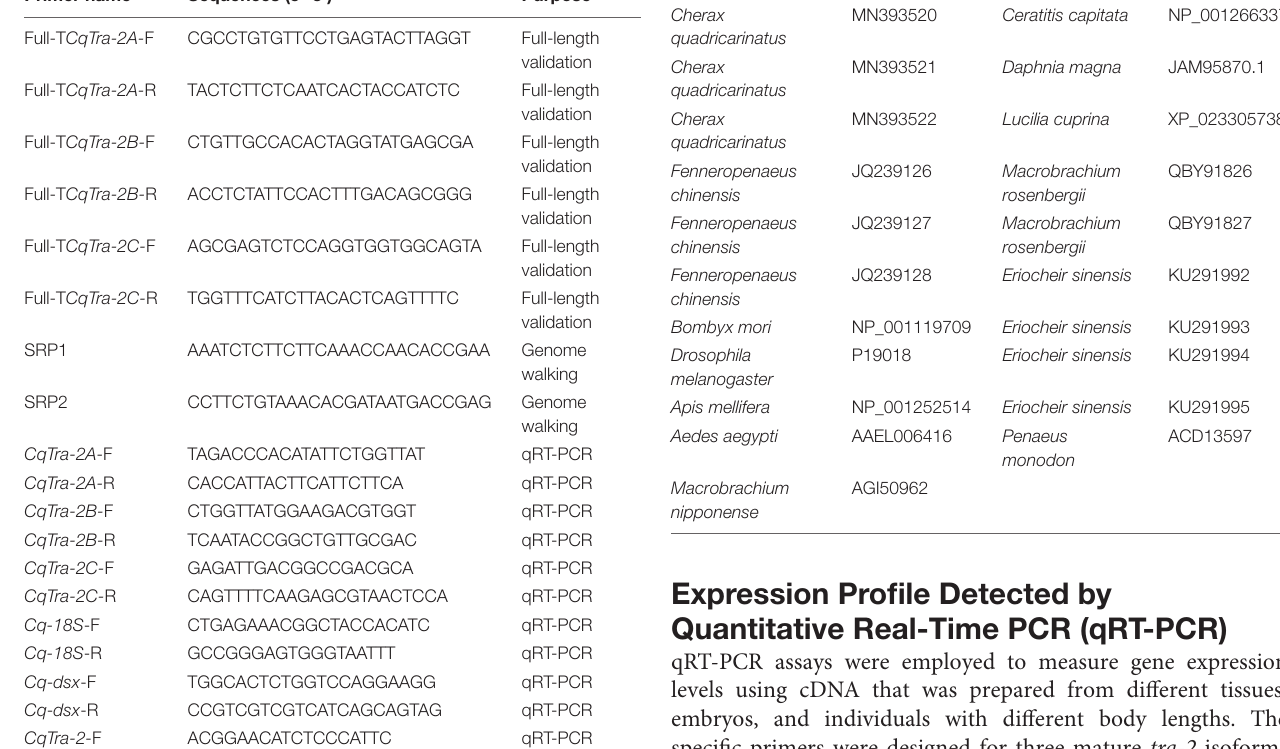
TABLE 1 | Primers used for gene expression analysis of CqTra-2 in C. quadricarinatus. Primer name